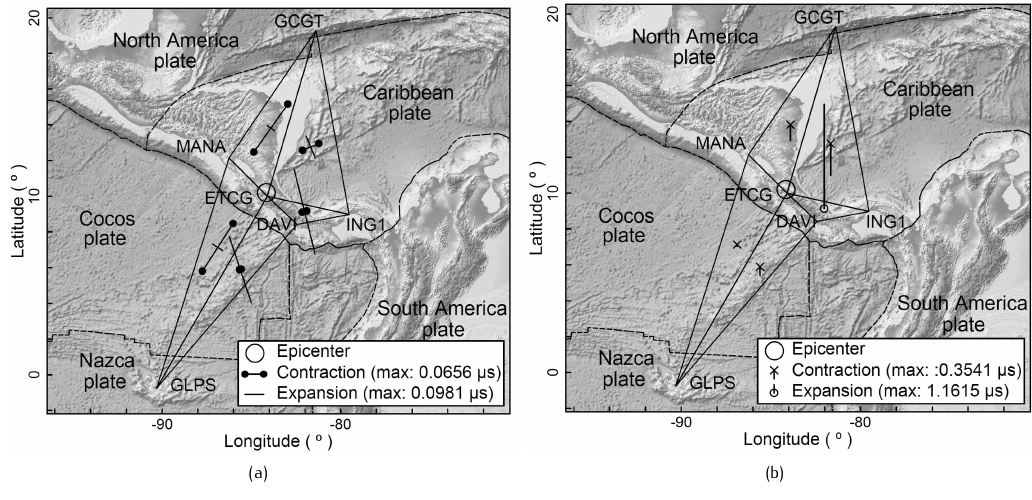
Figure 6. a) Principal components of planimetric strain to the seismic event of 02/27/2010. b) Principal components of altimetric strain to the seismic event of 02/27/2010.